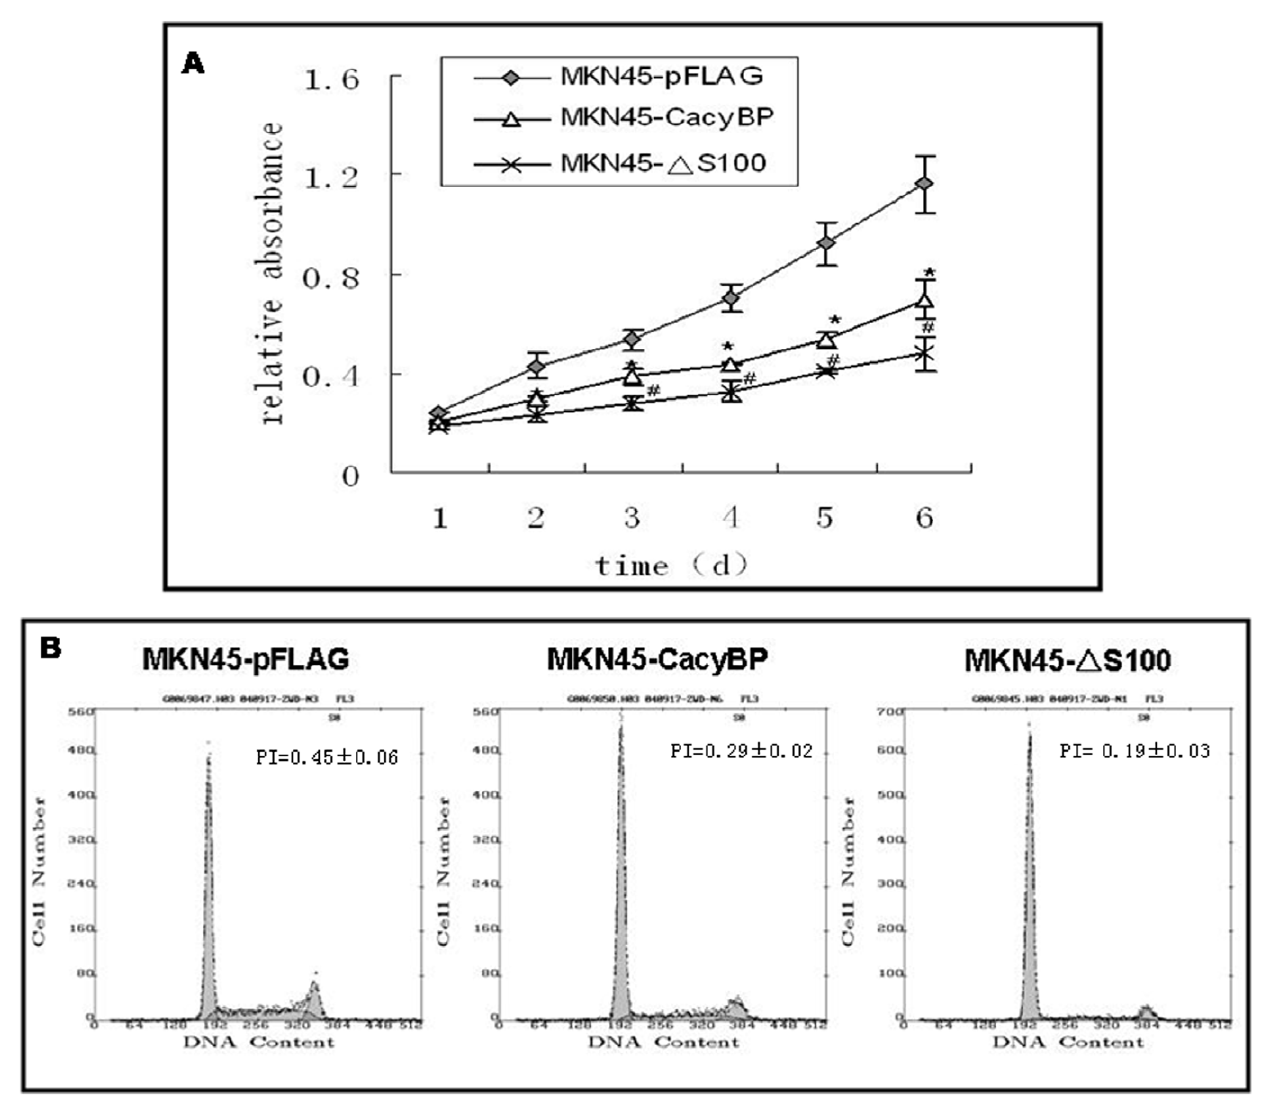
Figure 3. Effects of CacyBP/SIP on cell proliferation invitro . (A) Detection of the cell growth rate in vitro . Cell number was evaluated by absorbance at 490 nm using the MTT assay at the indicated times. The value shown is the mean of three determinations. (B) Cell cycle distribution and proliferative indices (PI) of the transfected cells. The cells were detergent extracted, stained with propidium iodide, and analyzed by flow cytometry. PI=(G2 + S)/(G1 + S + G2).